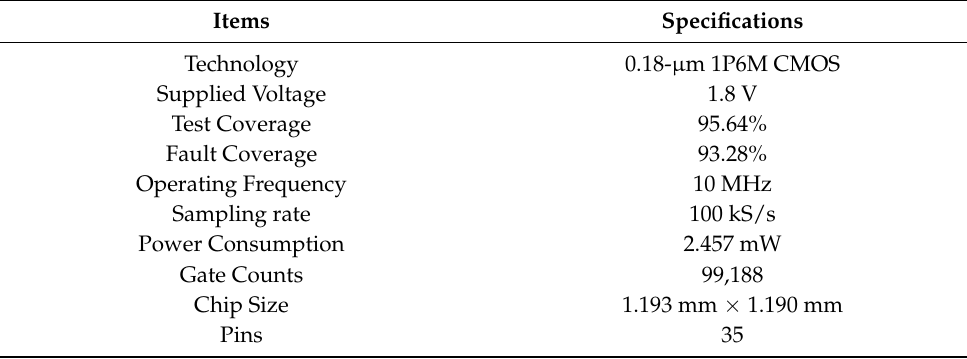
Table 9. System specifications of proposed MPDTC ASIC.